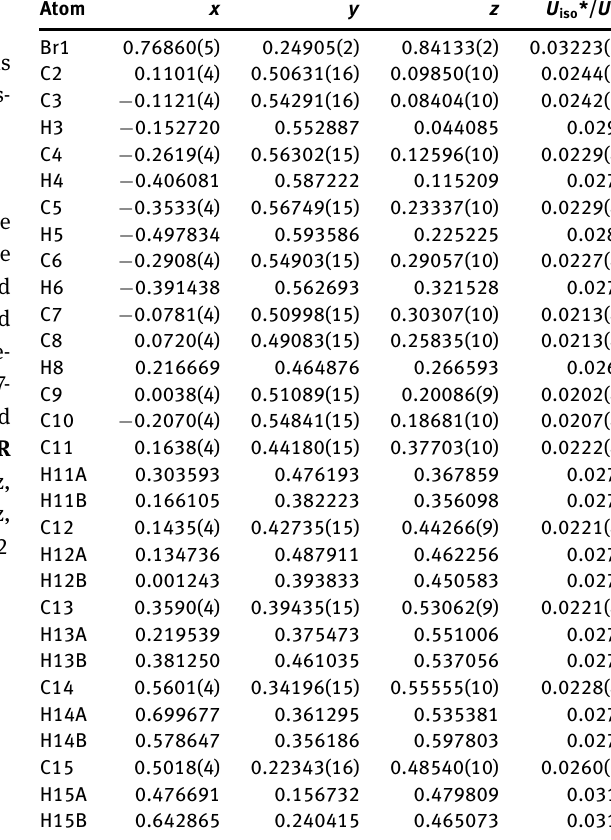
Table 2: Fractional atomic coordinates and isotropic or equivalent isotropic displacement parameters (Å 2